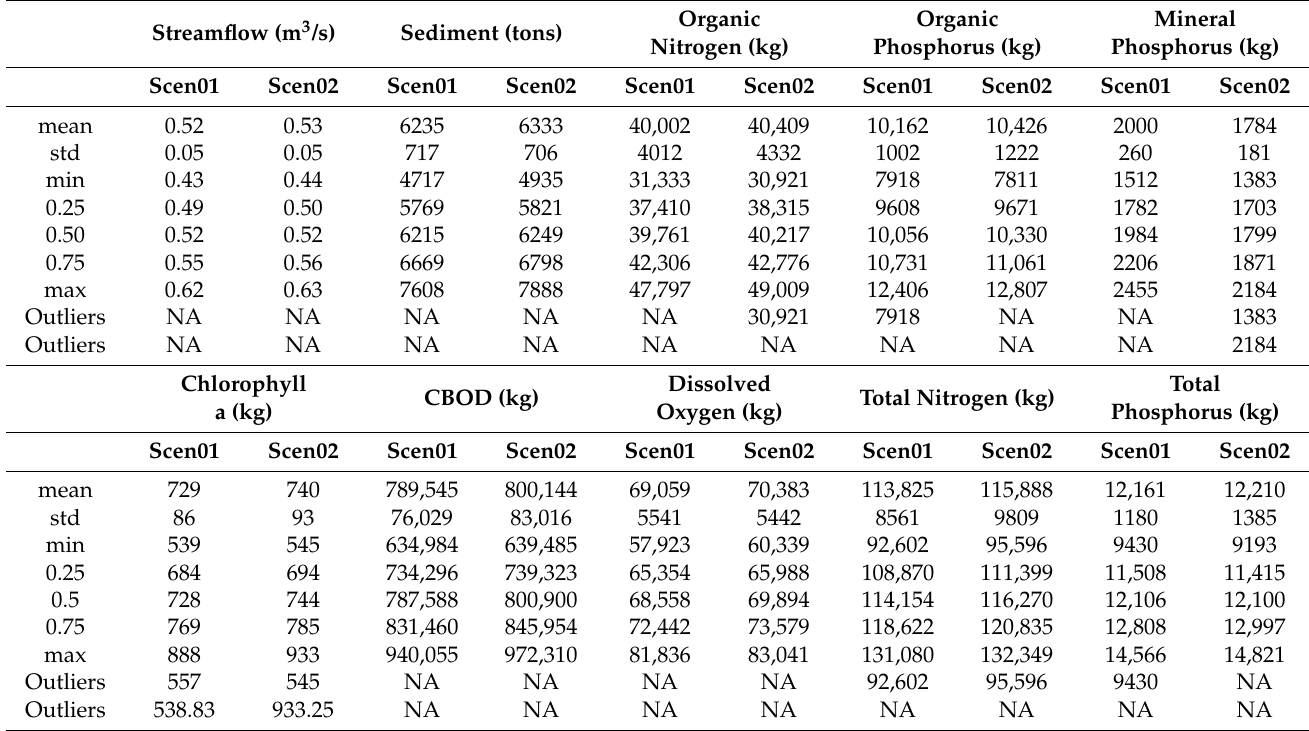
Table 5. Comparison between Scenario 1 and 2